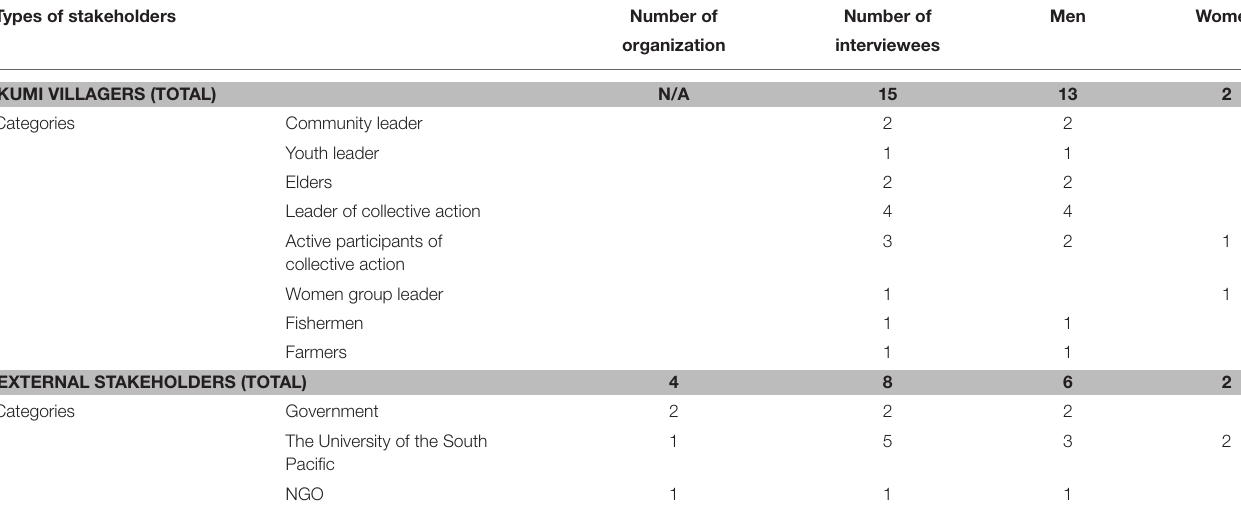
TABLE 1 | Number of villagers and other external stakeholders involved in this study. Types of